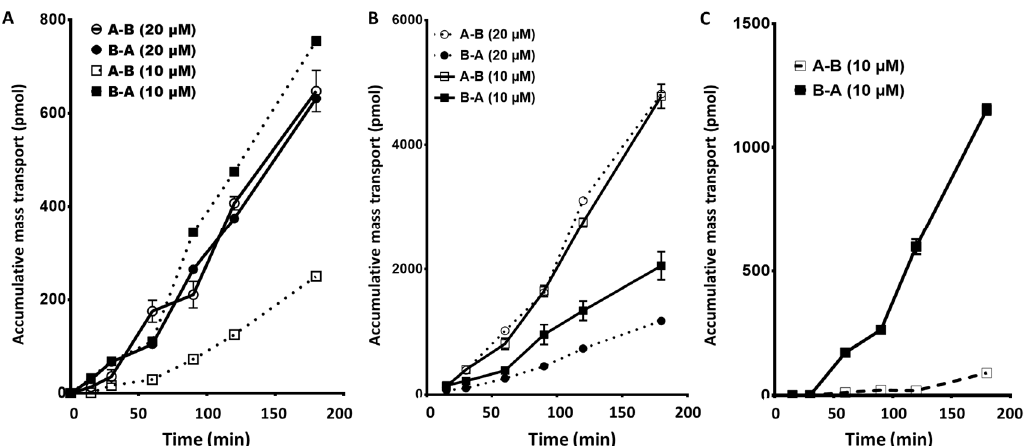
Figure 3. Cumulative transport of gefitinib ( A ), erlotinib ( B ), and afatinib ( C ) across a CaCo2 monolayer at both 10 and 20 µM concentration in the apical to basolateral (A – B) and the basolateral to apical (B – A) directions. Values are the mean ± standard error of the mean of 3 replicates. When not visible, the error bars are within the size of the marker.